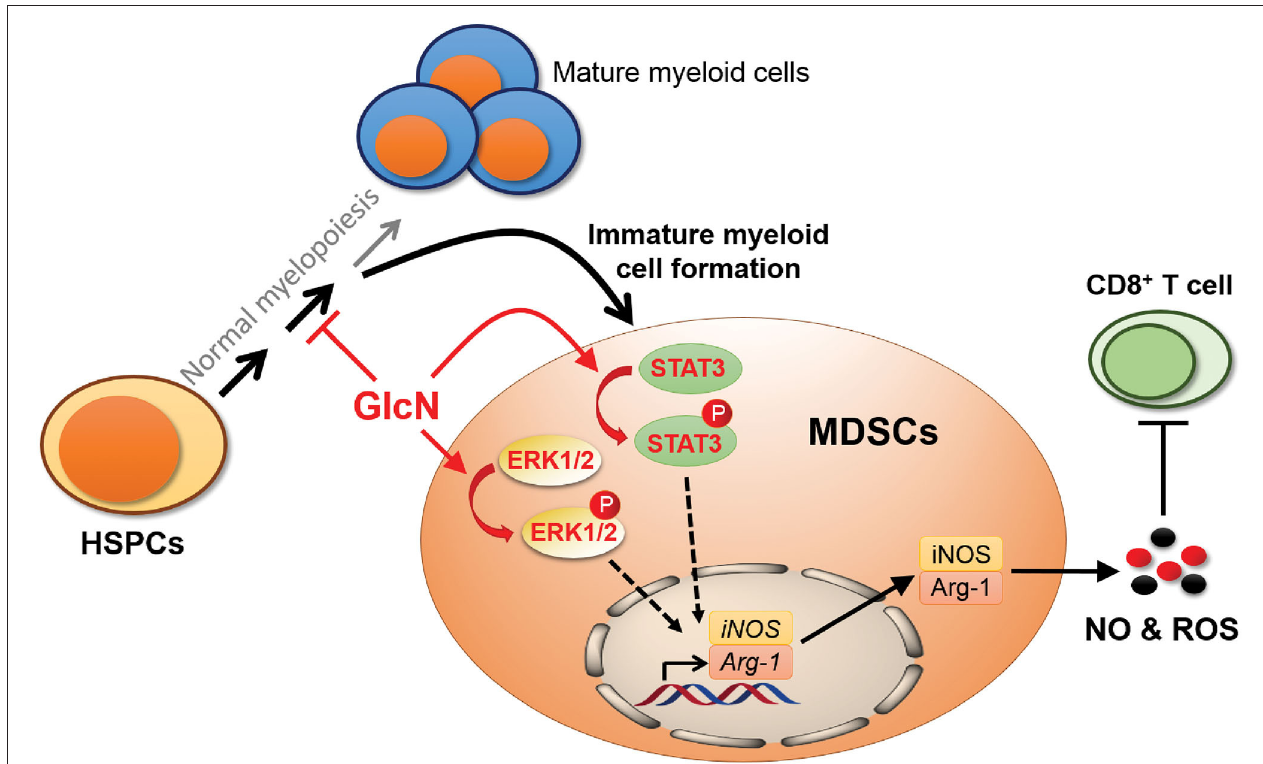
FIGURE 9 | Schematic illustration showing the influence of GlcN in myelopoiesis and MDSC functions. GlcN interferes myelopoiesis by downregulating the gene expression of critical transcription factors and cytokines involved in HSPC differentiation and myelopoiesis to produce more immature myeloid cells, MDSCs. In addition, GlcN increases STAT3 and ERK1/2 phosphorylation to enhance the MDSC immunosuppressive ability. MDSC immunosuppressive activity on cytotoxic T cells via ERK1/2 pathway, GlcN prolongs ERK1/2 phosphorylation